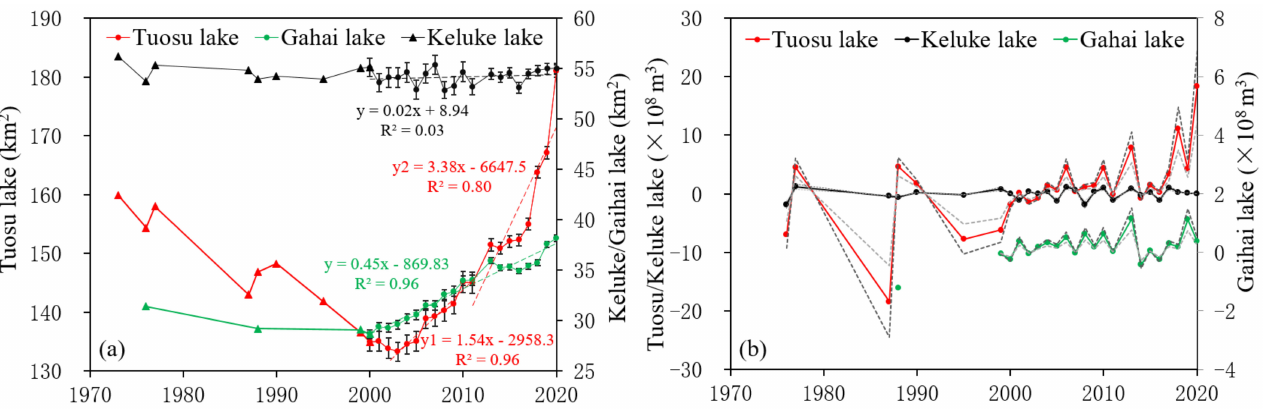
Figure 3. ( a ) Plot depicting the change of lake surface area in the study region extracted from Landsat satellite images. Triangles (before 2000) represent data in the literature [31,32]. y, y1, and y2 represent the least square fitting line of the surface area in Gahai Lake after 2000, Tuosu Lake from 2003 to 2011, and after 2011, respectively. Black error bar represents the uncertainty of the extracted lake surface area. ( b ) Calculated change in lake storage ( ∆ V ). The solid line, dashed lines in dark gray and light gray are the calculation results when the slope ( I ) is 3, 2, and 4,